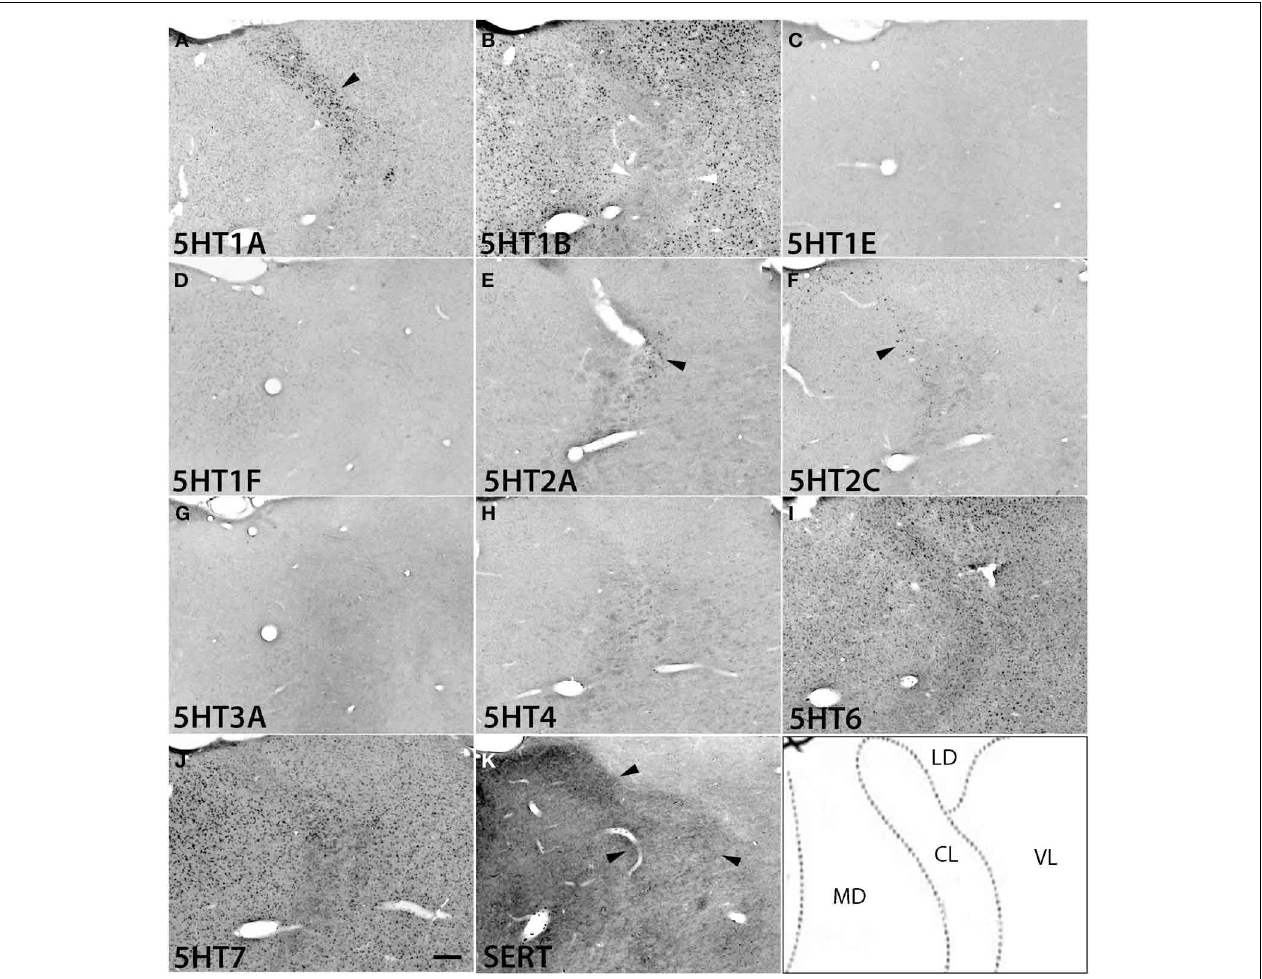
FIGURE 7 | ISH expression profiles of 5HTR s in thalamus. 5HTR mRNA expressions (A–J) and immunohistochemical staining with anti-SERT antibody (K) in central lateral (CL), mediodorsal (MD), lateral dorsal (LD), and ventral lateral (VL) thalamic nuclei. The black arrowheads in (A) , (E) , and (F) show the overlap of 5HT1A (A) , 5HT2A